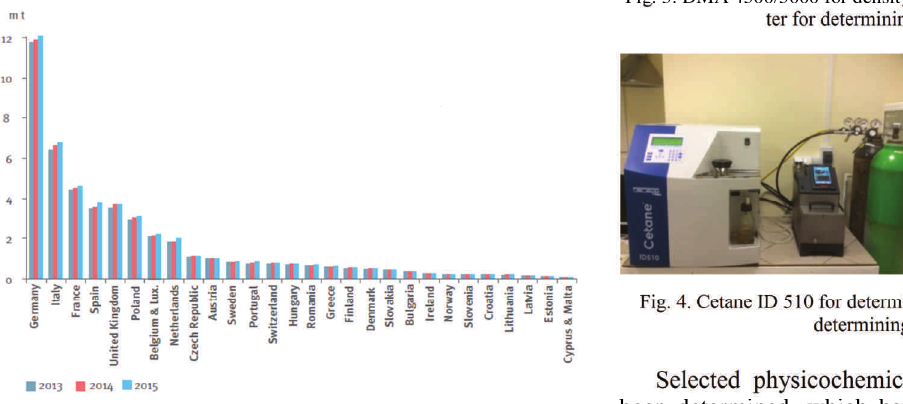
Fig. 4. Cetane ID 510 for determining a cetane number and Device for determining the flash